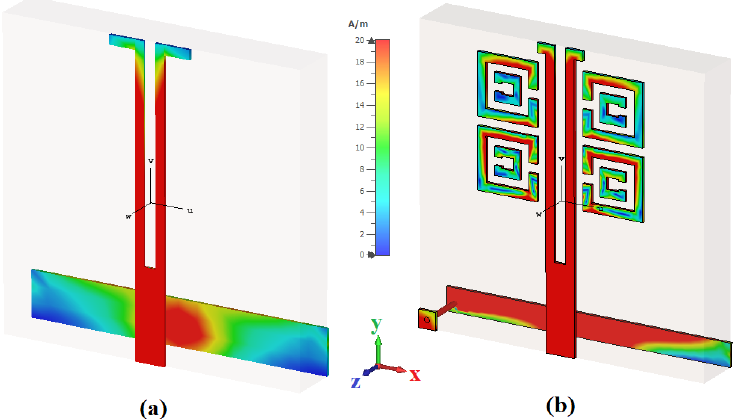
Figure 4. Surface current distributions of the one-element antenna at 5.8 GHz for: ( a ) dipole driven element and ( b ) dipole with